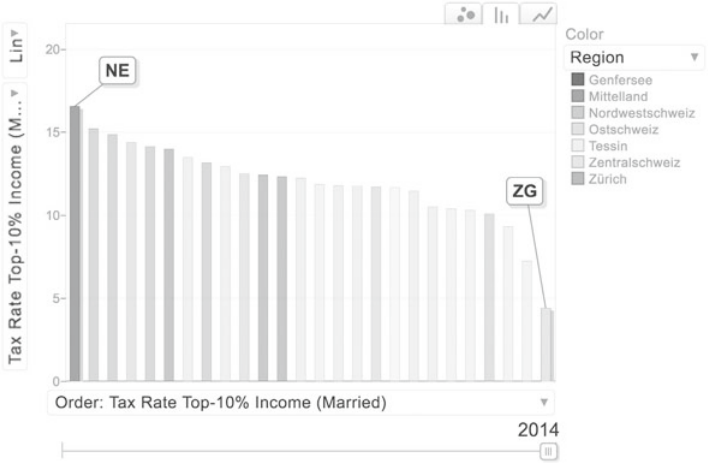
Figure 13: Ranking of consolidated cantonal + municipal effective average tax rate for a married couple without children and top-10% income across Swiss cantons in 2014. Average across municipalities weighted by the number of